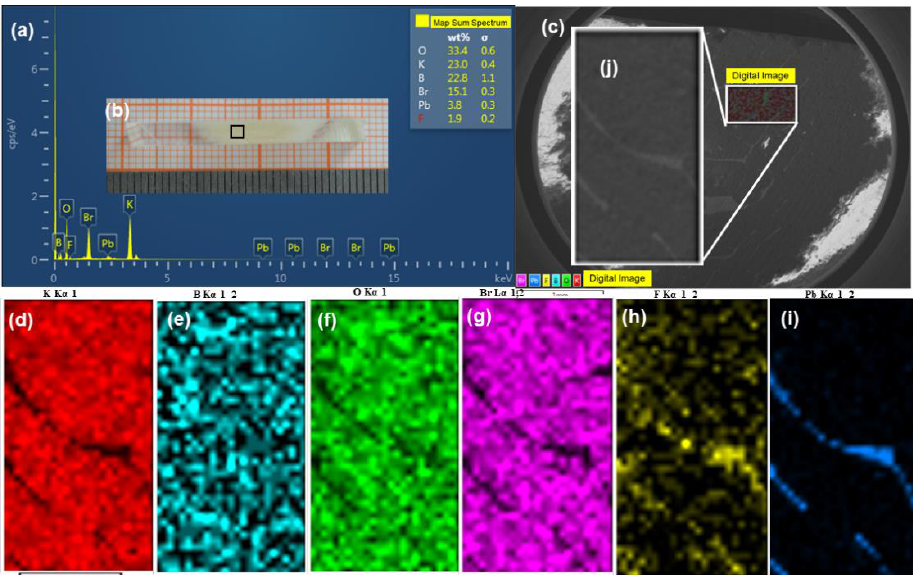
Figure 4. Element analysis of the inclusion zone of KBOB-L. ( a ) Element analysis photography. ( b ) The picture of KBOB crystal ( c ) Surface topography photography. ( d – h ), and ( i ) EDS digital images of elements K, B, O, Br, F, and Pb, respectively. ( j ) The SEM photograph of the inclusion zone KBOB-L.